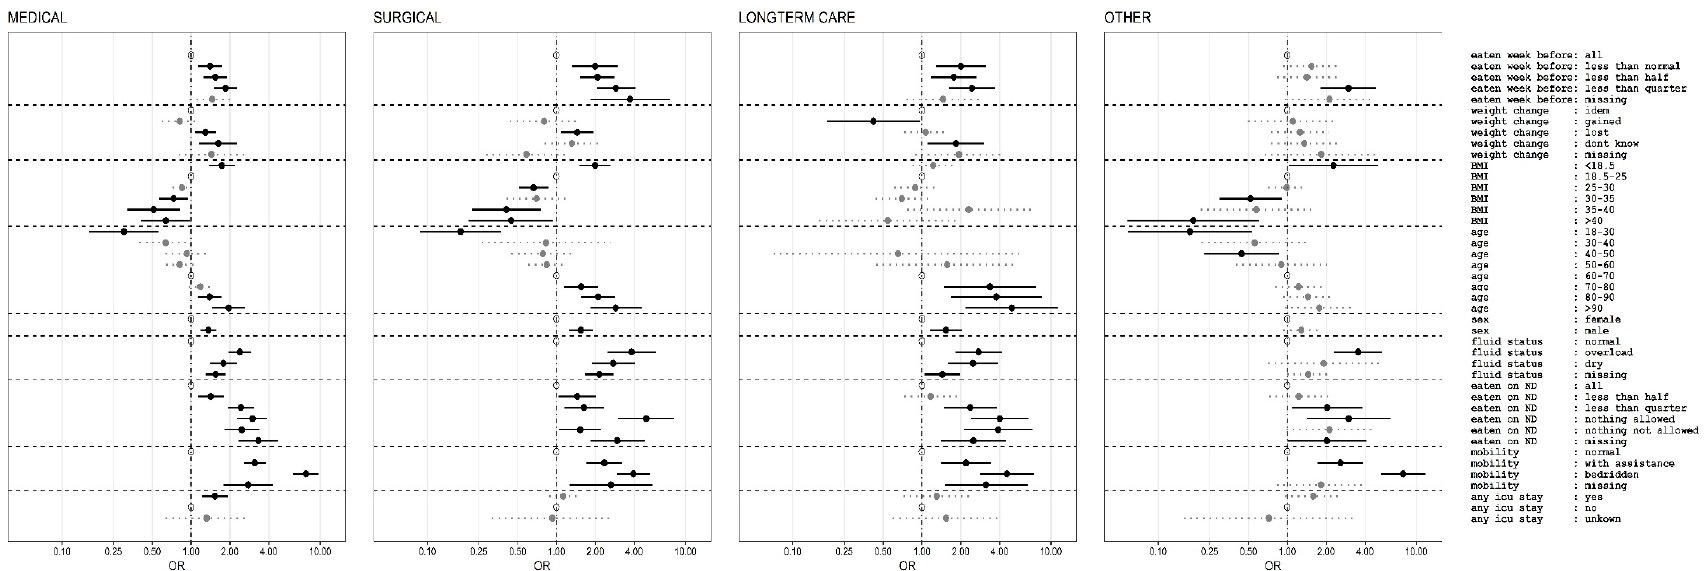
Figure 4. Multivariate analysis of association between demographic and nutrition related risk factors and death in hospital within 30 days after nutritionDay for medical, surgical, long-term care and other patient groups with the general linear model for logistic regression with wards as clusters and weighting of individual patients for sampling probability [25] and including all diagnostic categories and comorbidities (see Figure 5). Odds ratios (OR) with 95% confidence intervals indicated by horizontal line. Reference categories are indicated by an open symbol. Missing values are included in the model as individual categories.